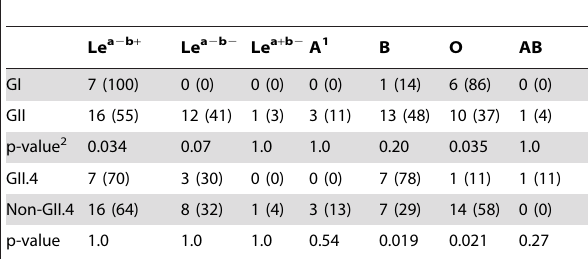
Table 4. Differences between NoV genogroups and genotypes regarding susceptibility patterns